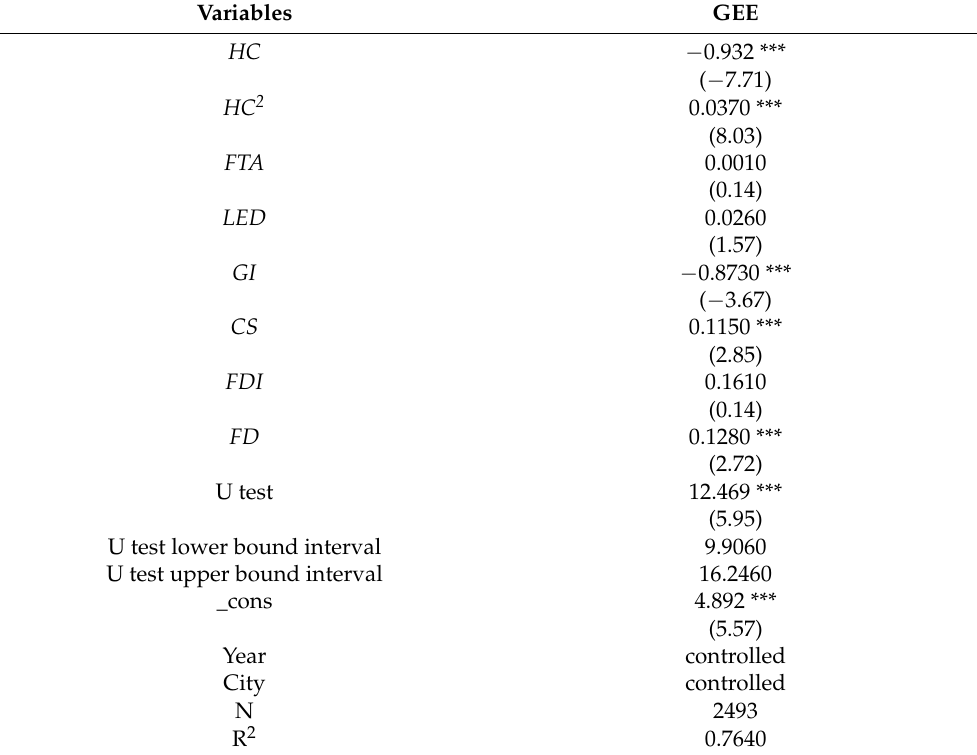
Table 3. Regression results of U-shaped relationship between HC and